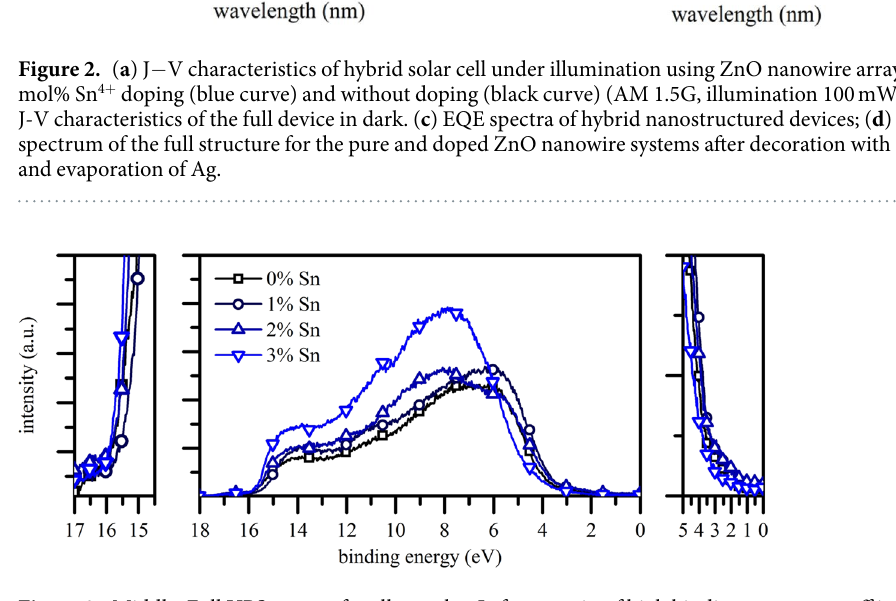
Figure 3. Middle: Full UPS spectra for all samples; Left: zoom-in of high binding energy cut-off in order to determine the sample work function (solid line); Right: zoom-in of low binding energy